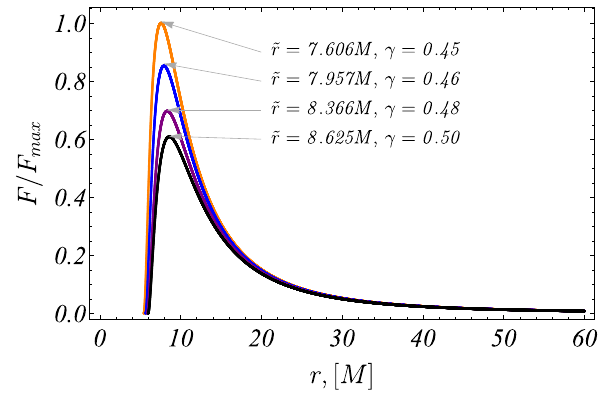
Fig. 16 Dependence of the radiation energy flux on the radial coor- dinate for the outer accretion disk. The curves for several values of the parameter γ are depicted in different colour, and the position of the flux maximum ˜ r is specified next to each curve. All the curves are normalized by the maximum of the energy flux for γ = 0 . 45